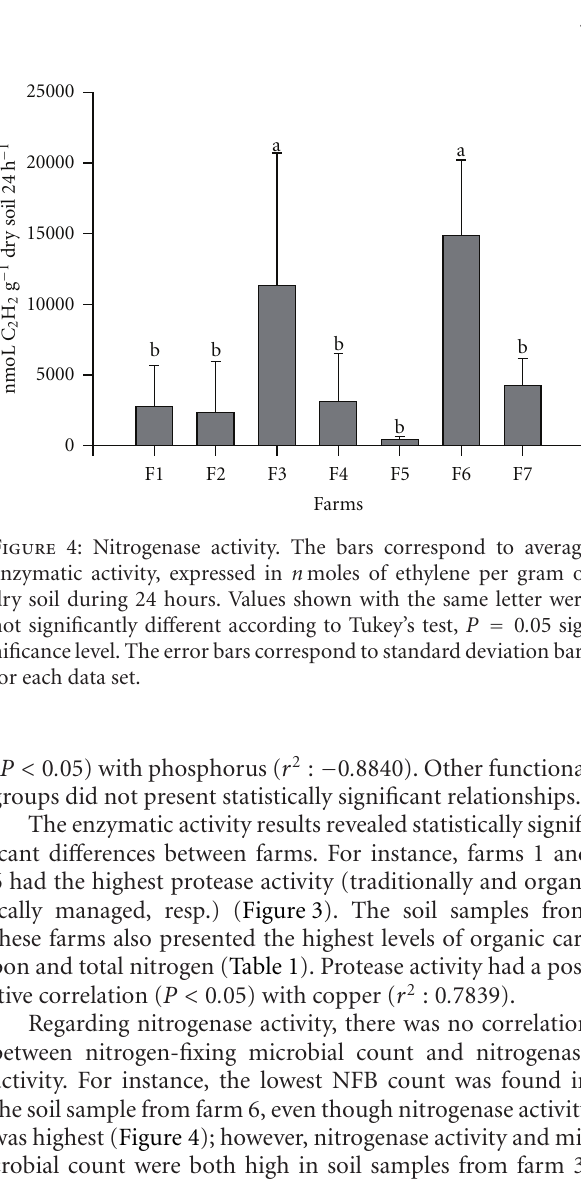
Figure 3: Protease activity. The bars correspond to average enzy- matic activity, expressed in µ g of tyrosine per gram of dry soil dur- ing 2h − 1 . Values shown with the same letters were not significantly di ff erent according to Tukey’s test, P = 0 . 05 significance level. The error bars shown correspond to standard deviation for each data set.